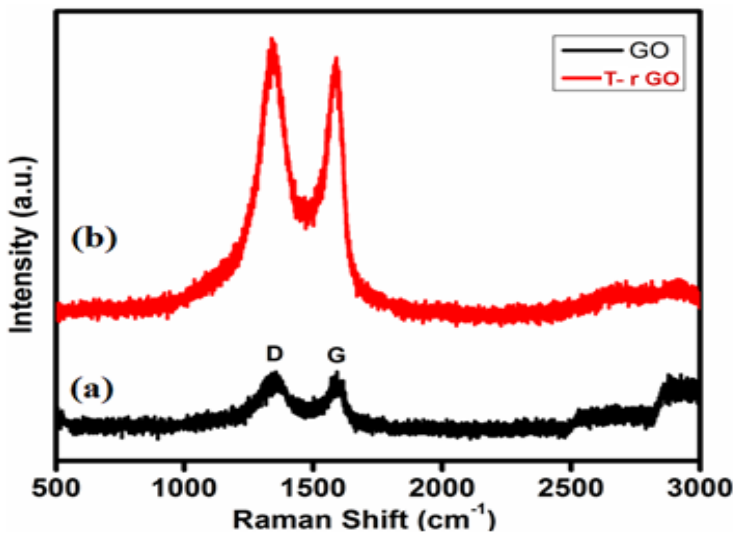
Figure 5. Raman spectra of (a) GO and (b) T-rGO.